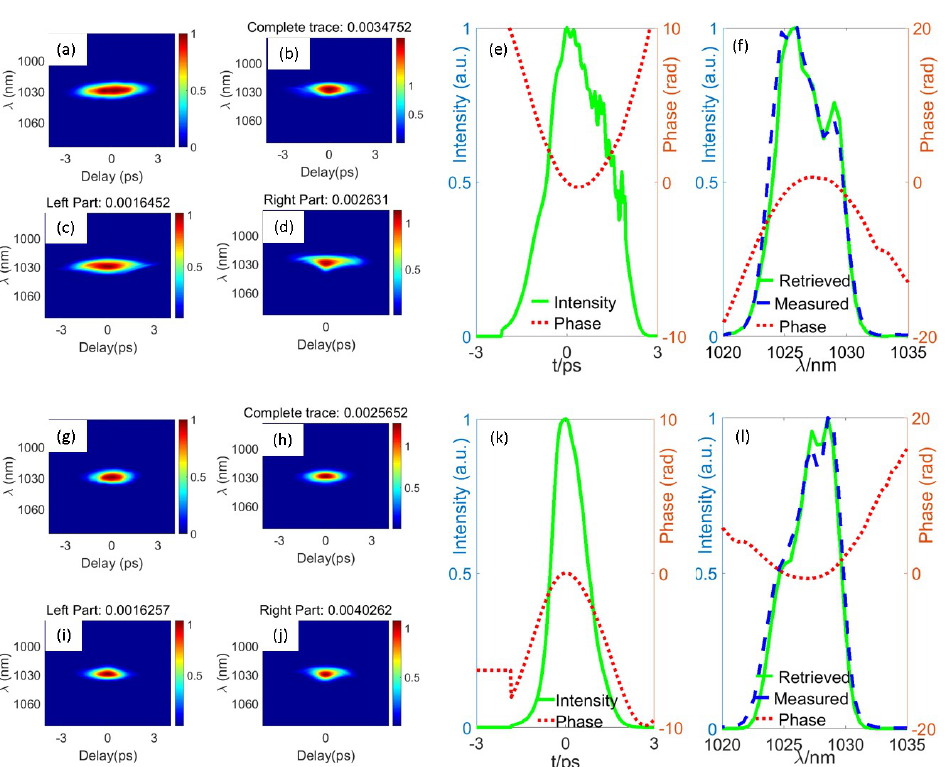
Figure 6. Experimental pulse reconstructions of two shots using our homemade ps − THG − FROG setup on 100- µ J ps − laser system. The reconstructed results are divided into two groups with different pulse widths. ( a , g ) present the recorded THG − FROG trace. ( b , h ) present the reconstructed trace using complete trace retrieval algorithm. ( c , i ) show the reconstructed trace using half-trace retrieval algorithm using negative delay range, while ( d , j ) show the same using a positive delay range. The reconstructed errors between measured and reconstructed trace are presented on top of the reconstructed trace. ( e , k ) show the reconstructed pulse distribution with the smallest reconstructed error in temporal domain, while ( f , l ) showed the reconstructed spectral distribution compared with their corresponding measured spectra (blue dashed